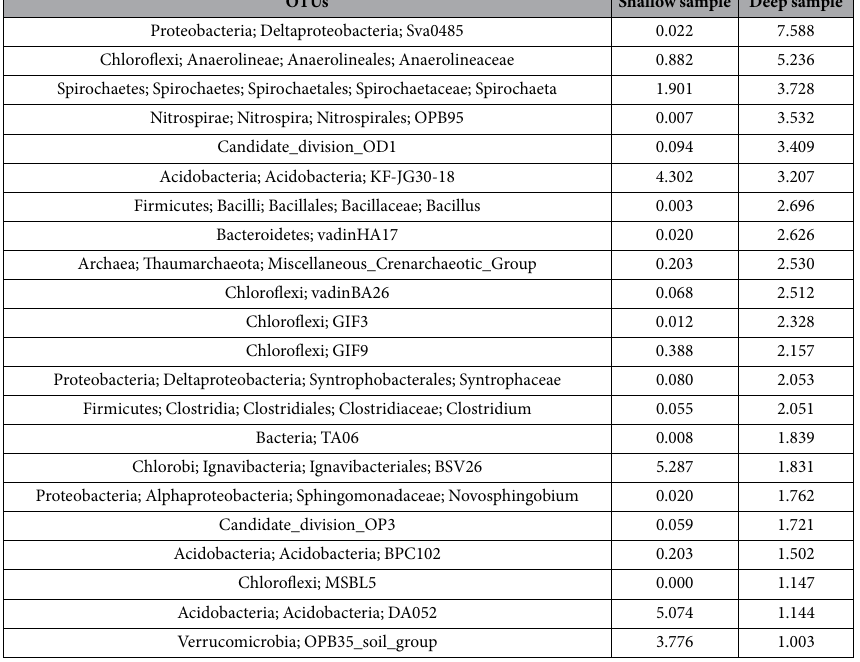
Table 4. Prokaryotic OTUs % at genus level (with cutoff > 1%) sorted by decreasing abundance in the 280 cm- deep